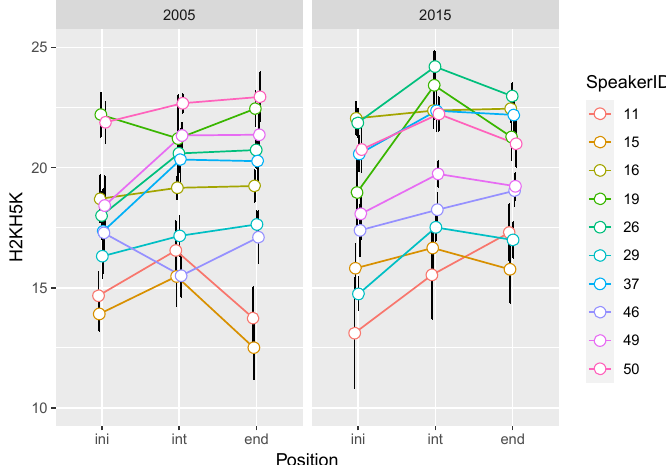
Figure A5. Speaker-specific data for H42K .